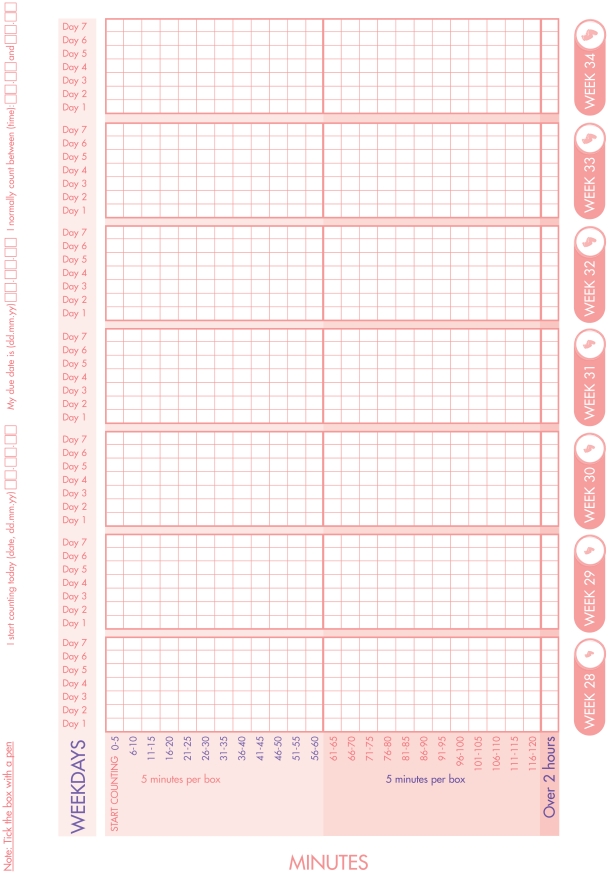
The fetal movement counting chart (the first of two pages).